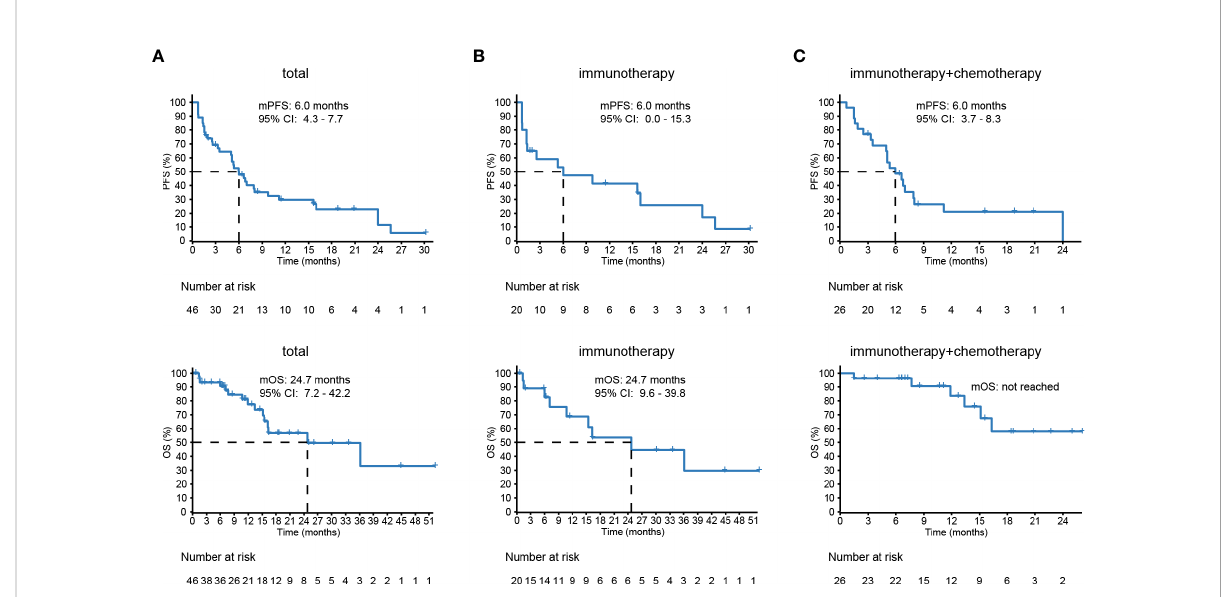
FIGURE 5 The survival of lung adenosquamous carcinoma (ASC) patients receiving immune checkpoint inhibitor (ICI) – based treatments. (A) Forty-six patients with advanced or recurrent lung ASC from eleven different centers show a median prognosis-free survival (PFS) of 6.0 months and overall survival (OS) of 24.7 months. (B, C) The PFS and OS of 20 patients treated with immunotherapy and 26 patients with